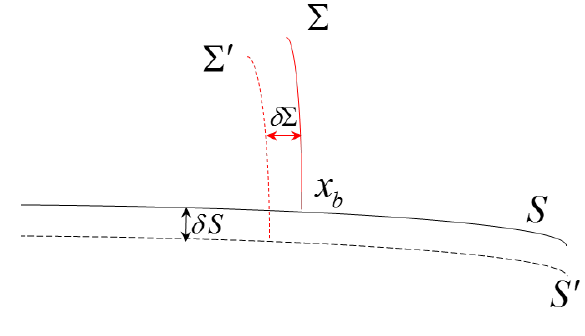
Figure 2. Scheme of shock perturbation. Figure 1. Scheme of shock location and conventions.